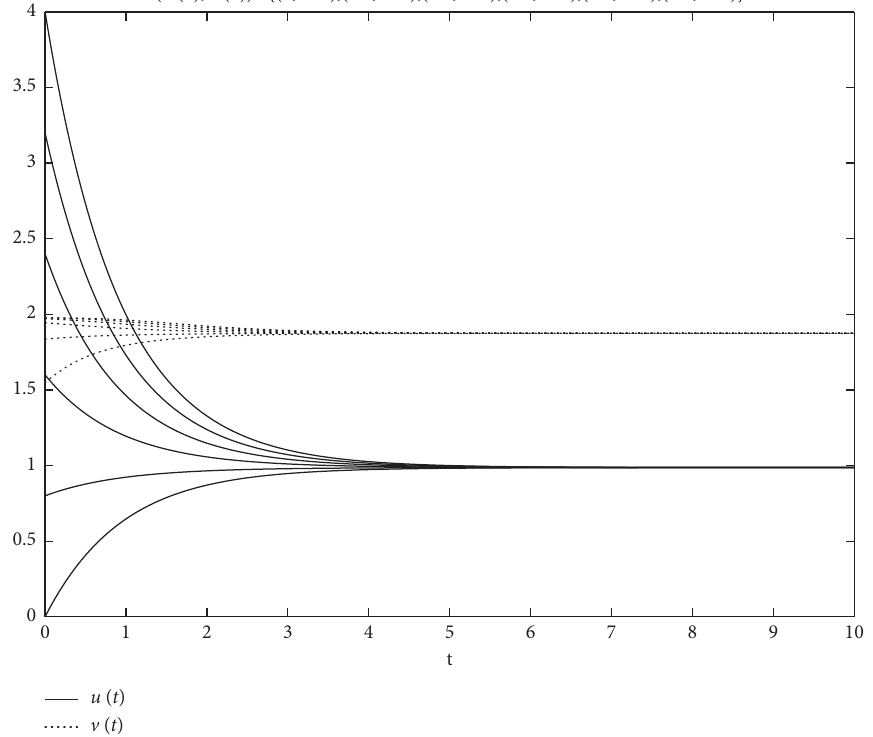
( t ) ,y ( t )) , ( x ( t ) , y ( t )) of models (57) and (58) with consistent initial values x 1 1 2 2